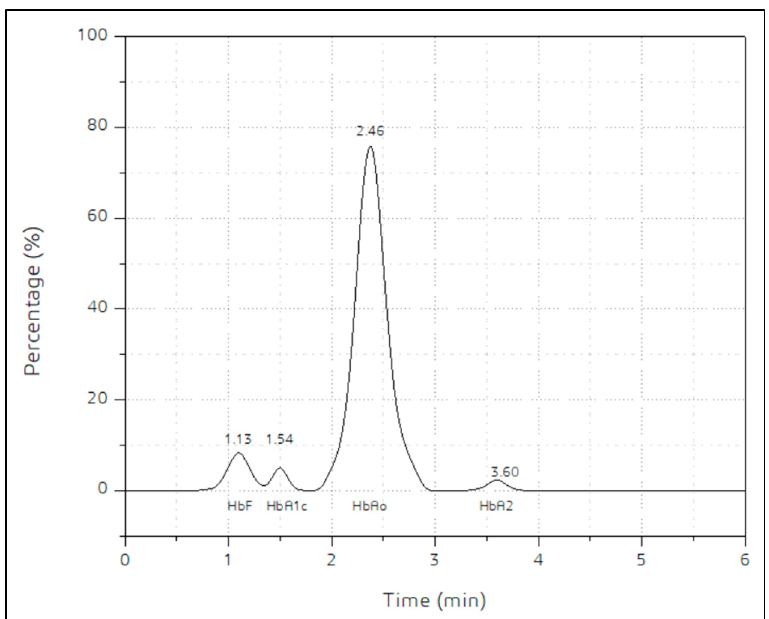
Figure A7. Chromatogram of cation exchange chromatography of impure hemoglobin solution.